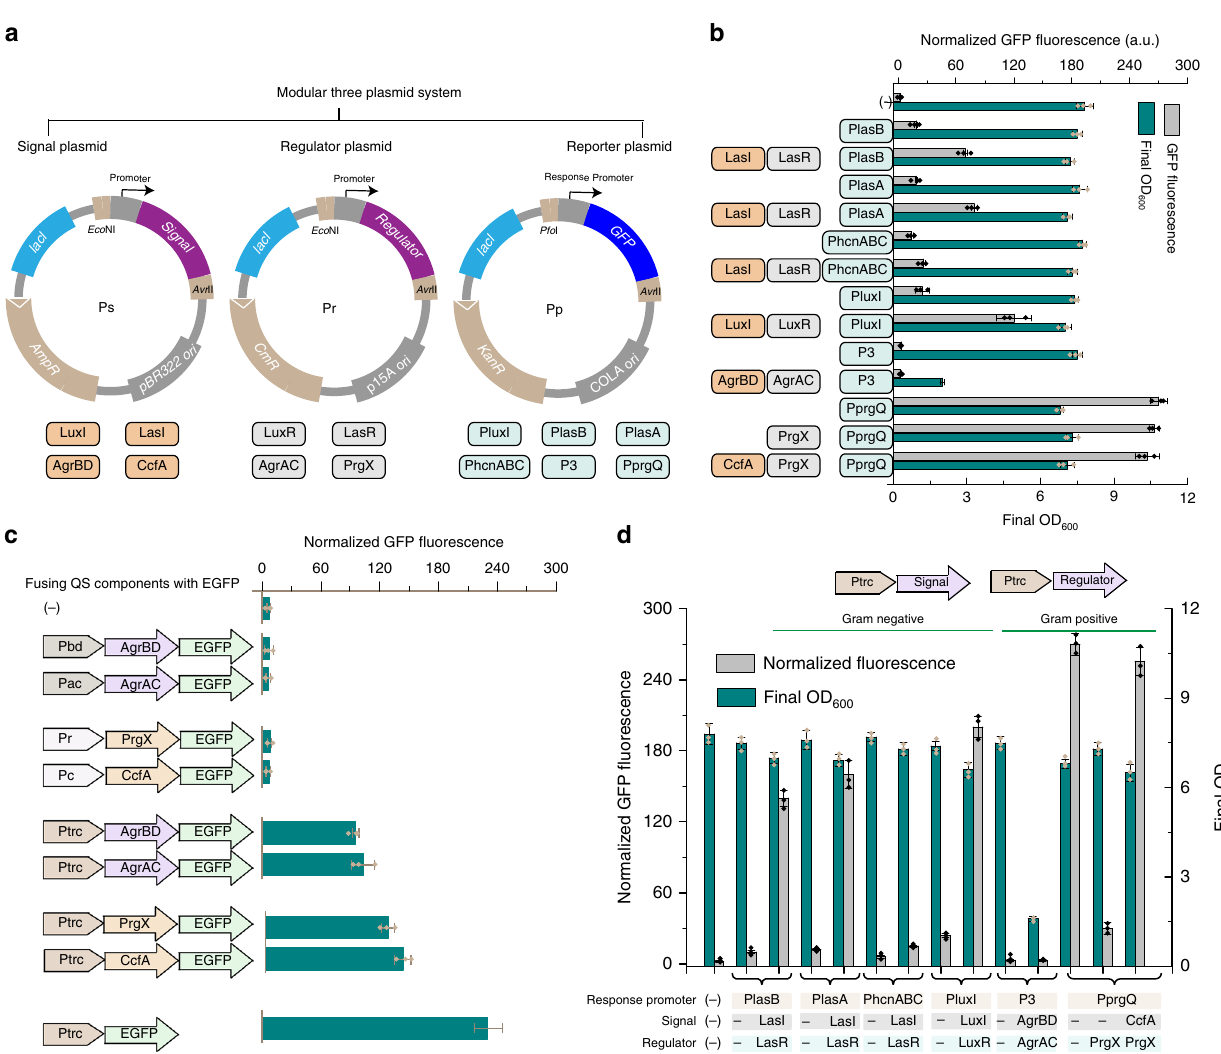
Fig. 1 Characterization of QS systems from both Gram-negative and -positive bacterial species. a Schematic of a modular three-plasmid system, including a signal plasmid (Ps), an regulator plasmid (Pr), and a reporter plasmid. b Validating the function of each QS system using native promoters for QS component expression. c Fusing QS components with GFP to measure translational output directly. Pbd, native promoter of AgrBD; Pac, native promoter of AgrAC; Pr, native promoter of PrgX; Pc, native promoter of CcfA; Ptrc, constitutive trc promoter. d Validating the function of each QS system using constitutive Ptrc promoters for QS component expression. The function of each QS system was validated by comparing normalized GFP fl uorescence from strains harboring plasmids of Ps, Pa, and Pp to strains only harboring Pp. All fl uorescence measurements were normalized by dividing measured fl uorescence values by the OD 600 of that well to conduct a per-cell measurement. The recombinant strains were grown in 25 mL of MOPS medium at 30 °C with 220 rpm orbital shaking. Cell fl uorescence and cell density (OD600) were measured after 30 h of culture on a Cytation 3 imaging reader system (BioTek, Winooski, USA). ( − ) indicated the wild type strain E. coli MG1655 with corresponding empty plasmids as the negative control. Values are shown as mean ± SD ( n = 3 biological replicates). Source data are available in the Source data fi